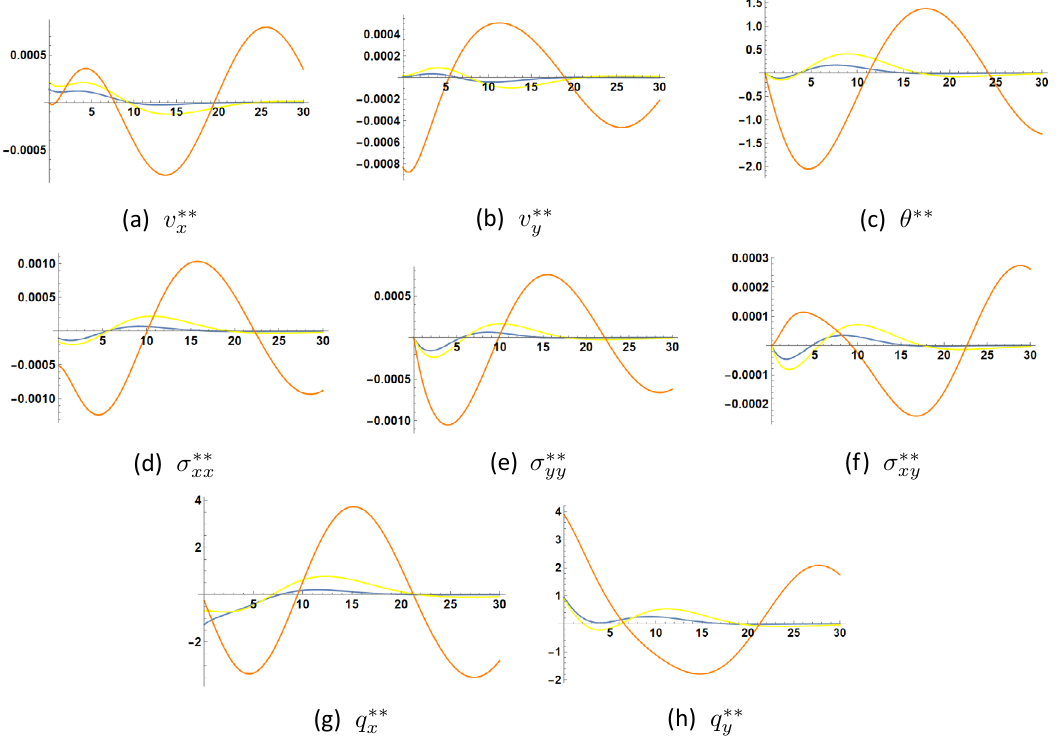
Figure 5. Second order solution as function of y at x = 0.1 , t = 1.5 for τ θ = 0.5 and three values of τ q • τ q =